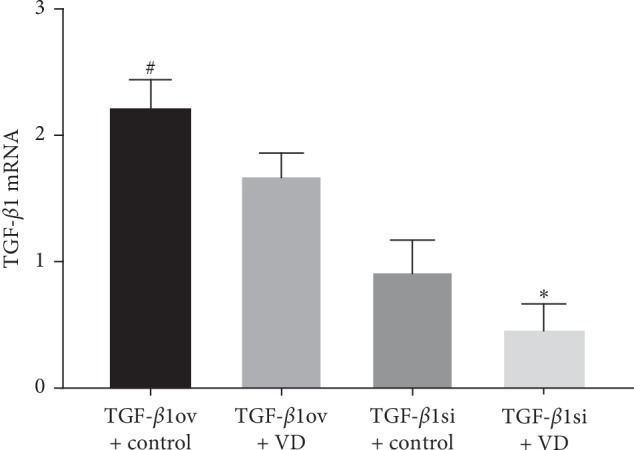
TGF-β1 mRNA expression. TGF-β1ov + control, TGF-β1 overexpression + oil; TGF-β1 ov + VD, TGF-β1 overexpression + 1,25(OH)2D3; TGF-β1si + control, TGF-β1 siRNA + oil; TGF-β1si + VD, TGF-β1 siRNA + 1,25(OH)2D3. ∗p < 0.05 vs TGF-β1si + control; #p < 0.05 vs TGF-β1ov + VD.